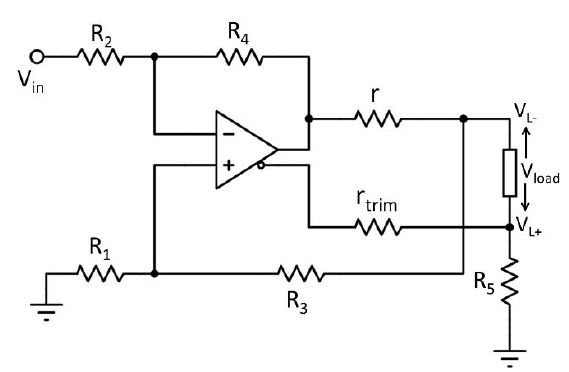
Fig.9: Modified Differential Enhanced Howland Current Source with differential amplifiers